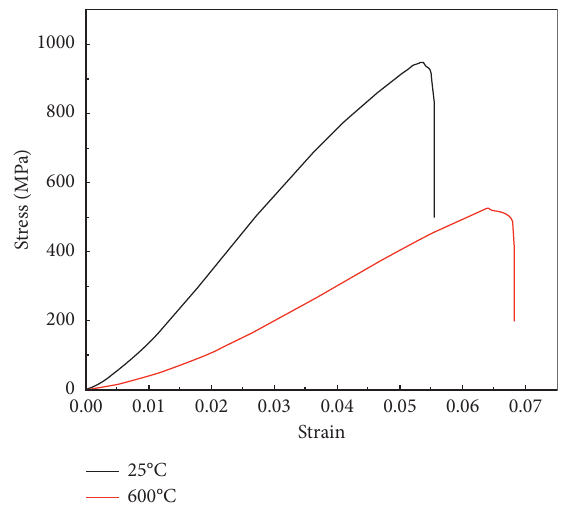
Figure 6: Curves for tensile mechanical properties of the